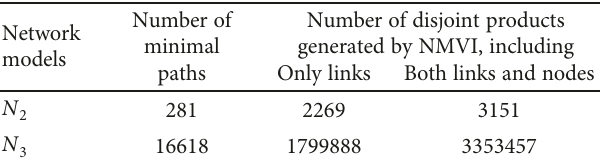
Figure 2: Network models with unreliable nodes: (a) 5-node, 7-link network ( N network ( N 3 Table 3: The number of disjoint products. Comparative results. Network models